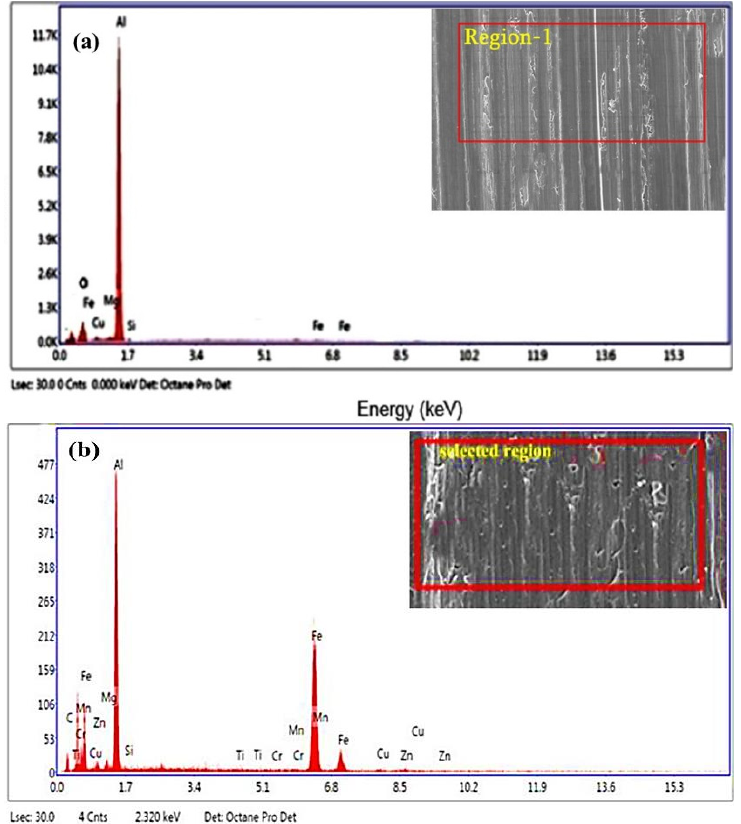
Figure 12. ( a , b ) Energy dispersive spectroscopy analysis of the worn surface of untreated and heat-treated Al2014-15 wt.% fine-sized alumina composite at 49.05 N, 600 rpm and 2000 m.